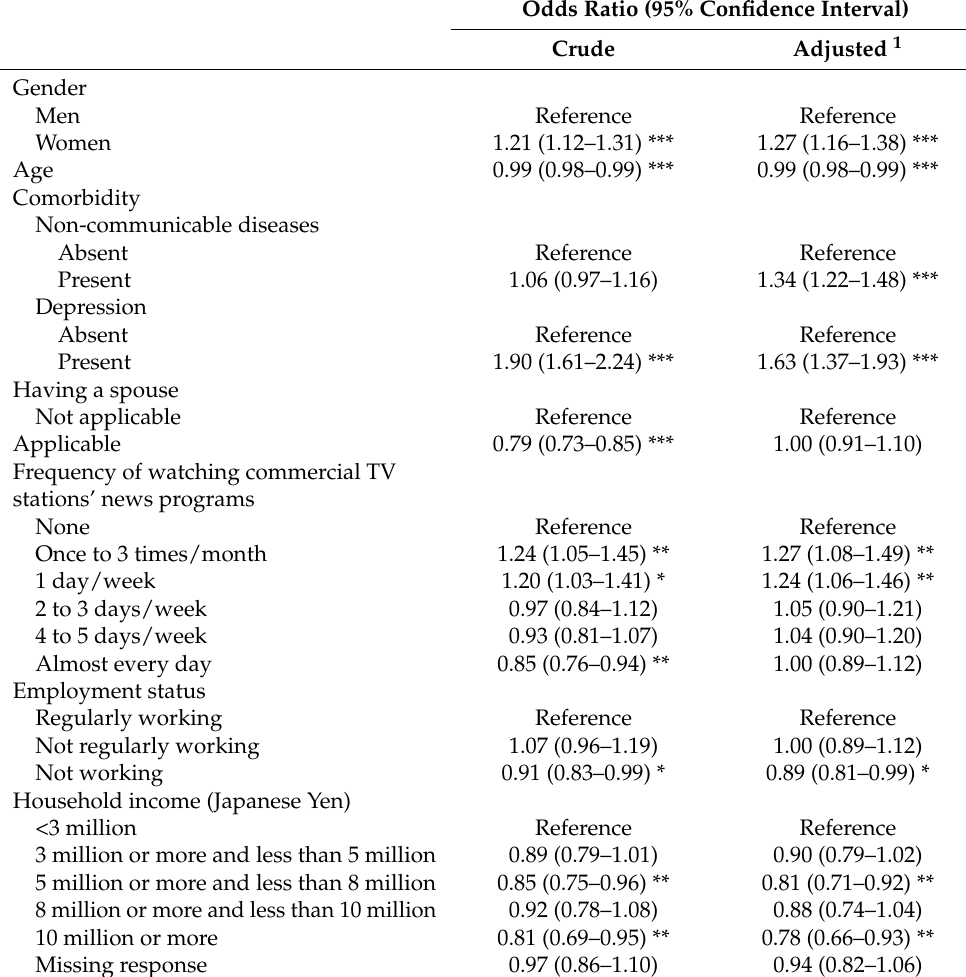
Table 7. Odds ratios for perceived susceptibility to COVID-19: multiple logistic regression